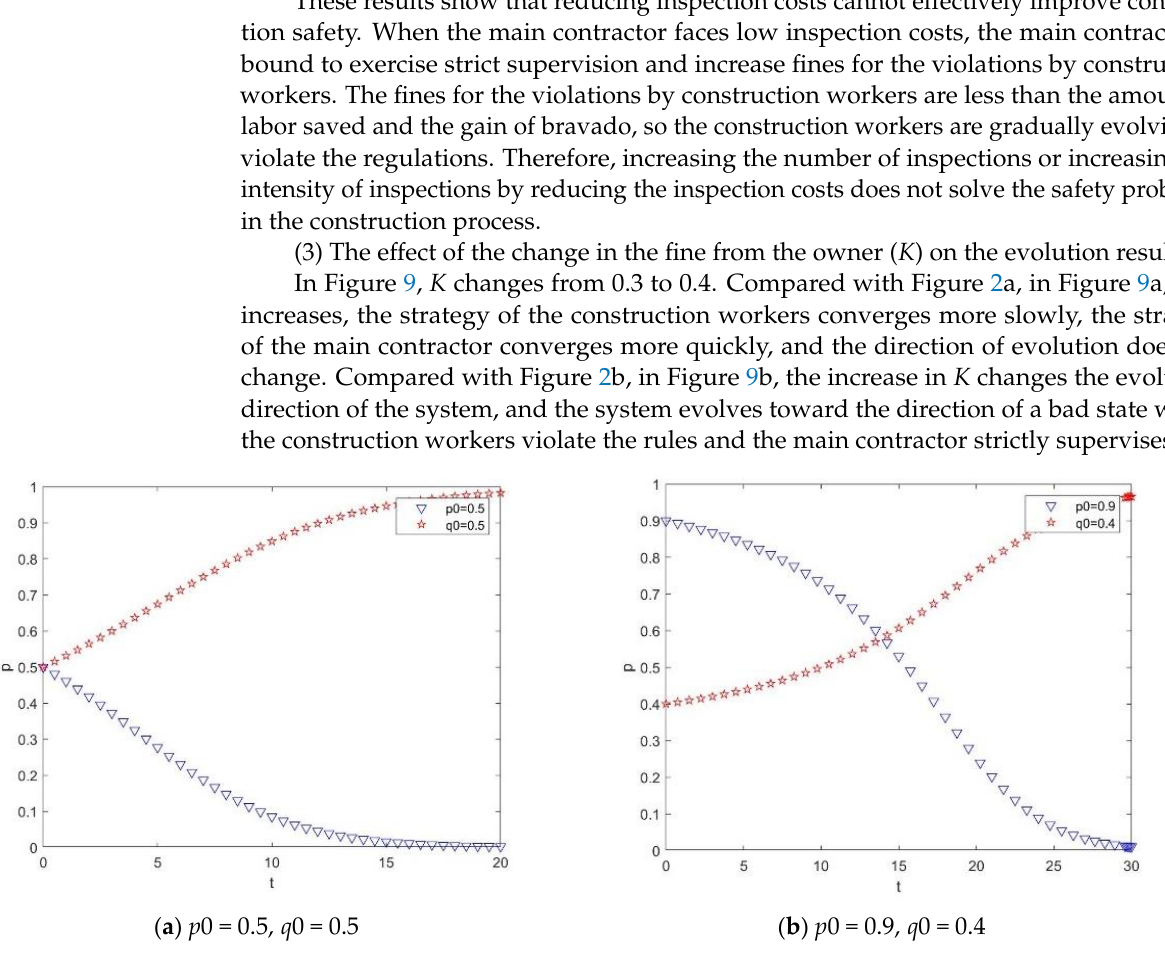
Figure 8. The effect of changes in inspection cost C 1 on the evolution results.